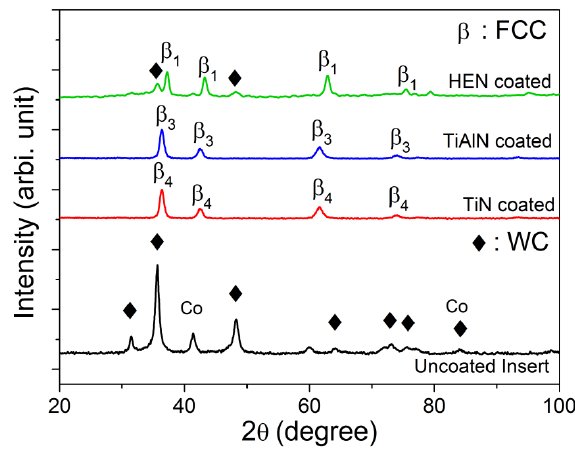
Figure 6. XRD patterns of uncoated, TiN, TiAlN, and (Al 0.34 Cr 0.22 Nb 0.11 Si 0.11 Ti 0.22 ) 50 N 50 coated